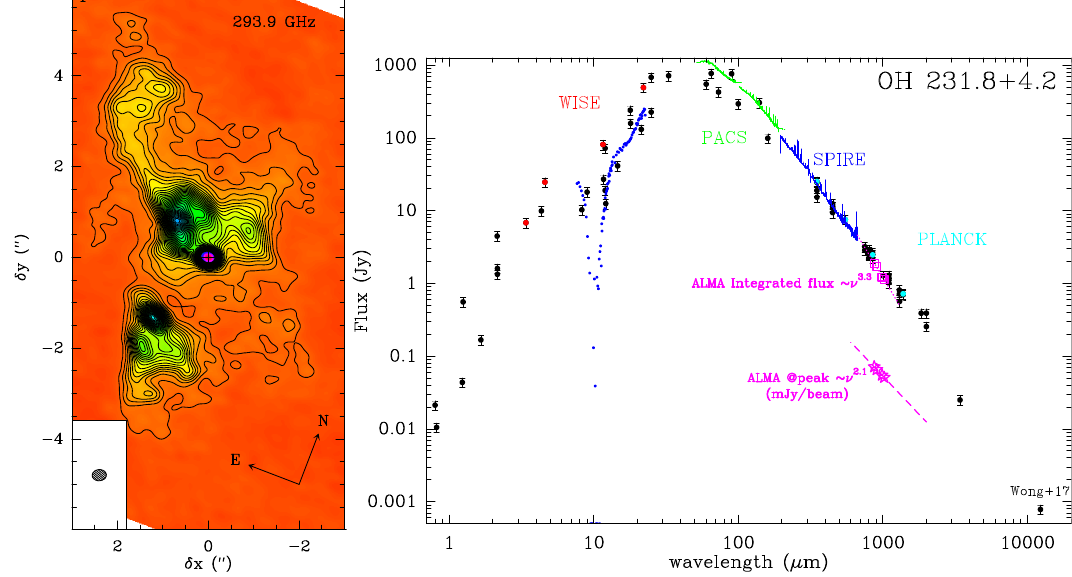
Figure 2. ( Left ) ALMA 294GHz-continuum emission map of OH231.8 + 4.2. Contour level spacing is 0.8mJy/beam. The clean beam (HPBW = 0. (cid:48)(cid:48) 31 × 0. (cid:48)(cid:48) 25, PA = − 84.5 ◦ ) is plotted at the bottom-left corner. The compact region at the centre where the continuum emission peaks is referred to as clump S and it is a dust (and gas) region enshrouding the AGB star QXPup. ( Right ) Spectral energy distribution. Pink symbols are our ALMA continuum measurements (squares = integrated flux; stars = peak-flux surface density at clump S ) and the dotted and dashed lines are S ν ∝ ν 3.3 and S ν ∝ ν 2.1 fitted to